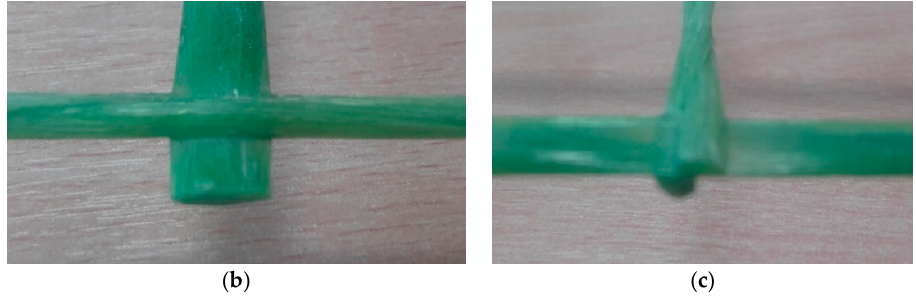
Figure 2. Different reinforcement bars: ( a ) schematic layout; ( b ) flat bar (0°); ( c ) twisted bar (90°).